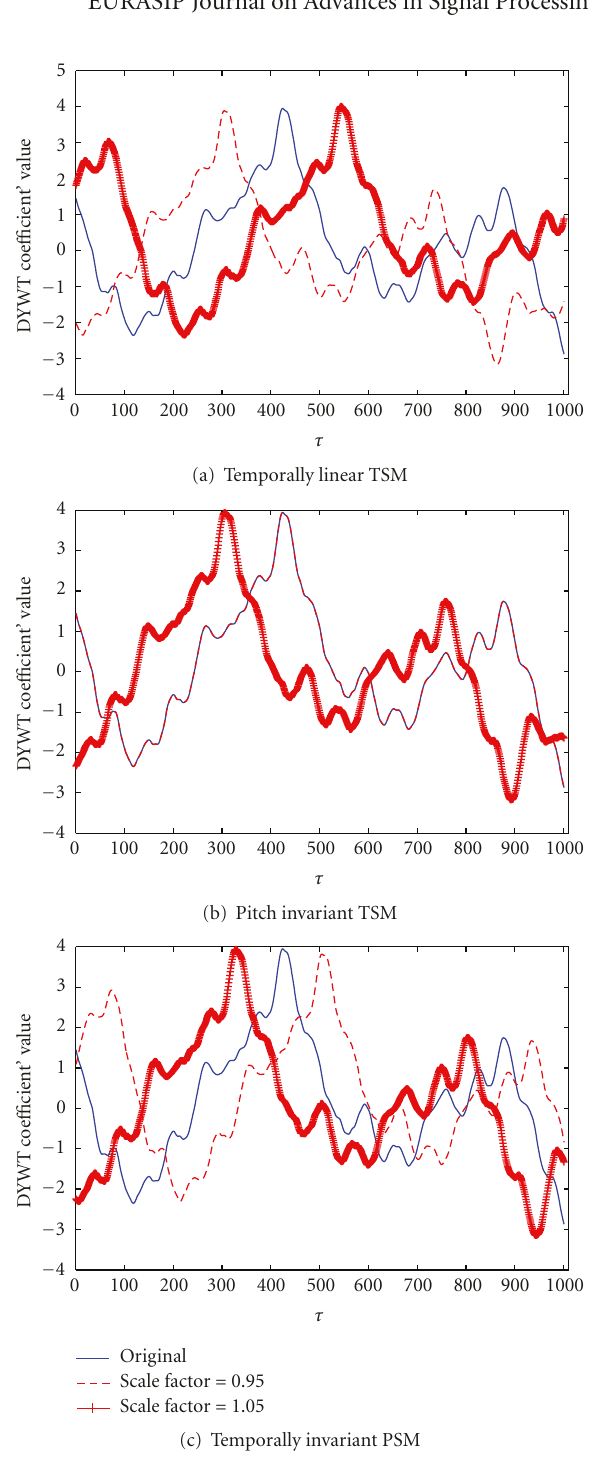
Figure 1: Invariance of DYWT to TSM and